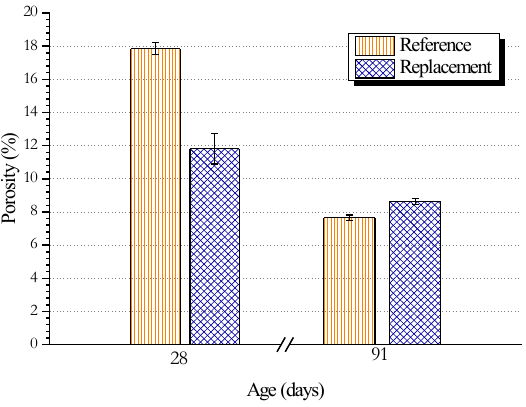
Figure 5. Results of the water absorption test after 28 and 91 days of